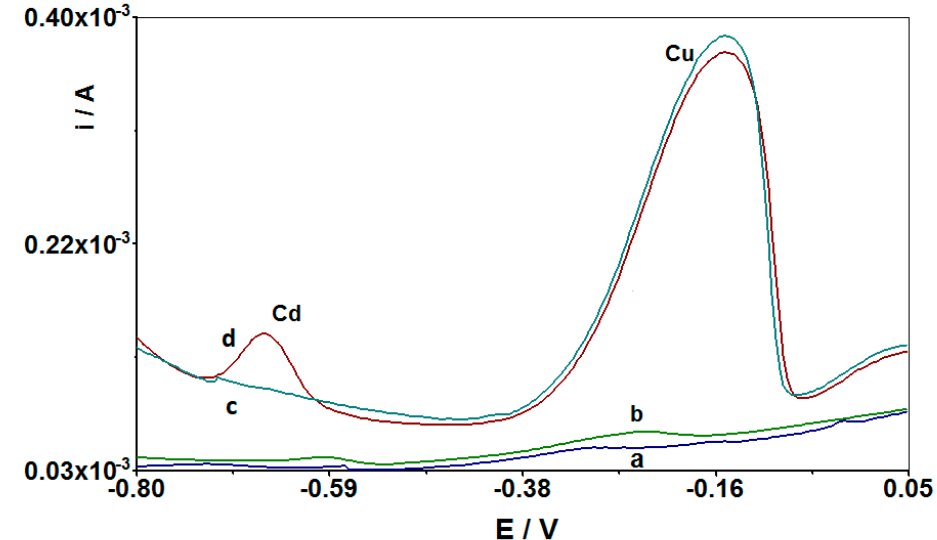
Figure 7. Comparison of differential pulse voltammograms obtained in the course of Cd(II) determination at the CuF/CN/SPE working electrode: ( a ) background, without addition of Cu(II) and Cd(II); ( b ) as ( a ) + 1 × 10 − 7 M Cd(II); ( c ) as ( a ) + 2 × 10 − 4 M Cu(II); and ( d ) as ( b ) + 2 × 10 − 4 M Cu(II). Accumulation potential and time was − 0.7 V and 210 s,